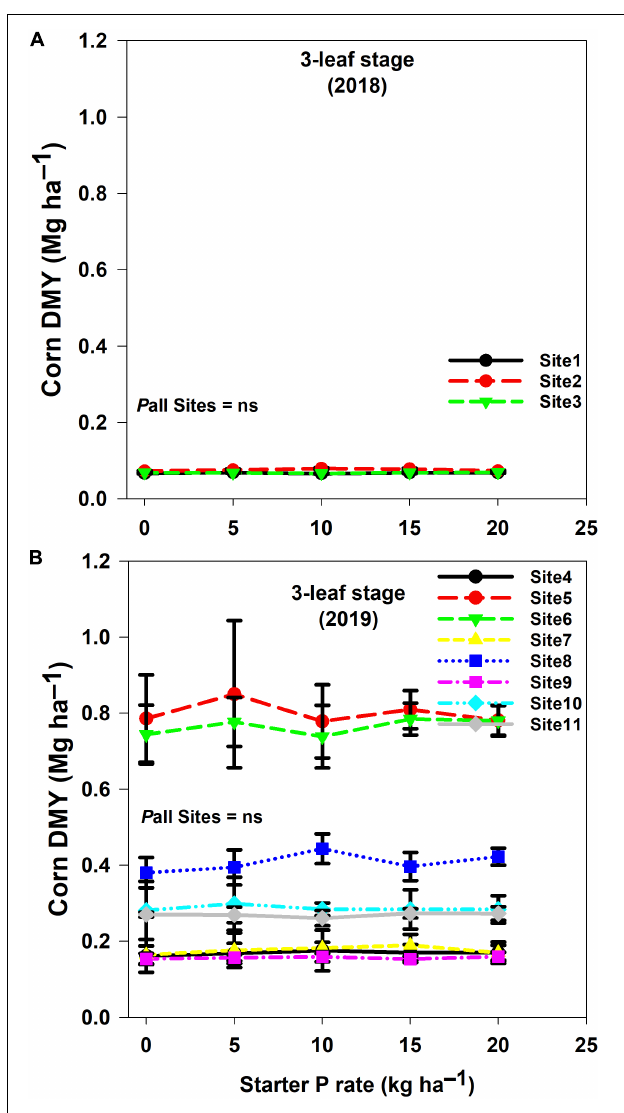
FIGURE 3 | Corn dry matter yield (DMY) at 6-leaf stage with application of starter P rates across 11 sites [2018 (A) and 2019 (B) ] in the Fraser Valley, BC. Error bars represent standard deviations of the